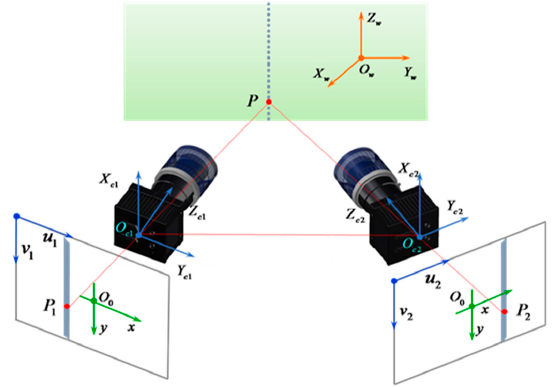
Figure 7. Illustration of the matching and reconstruction process.